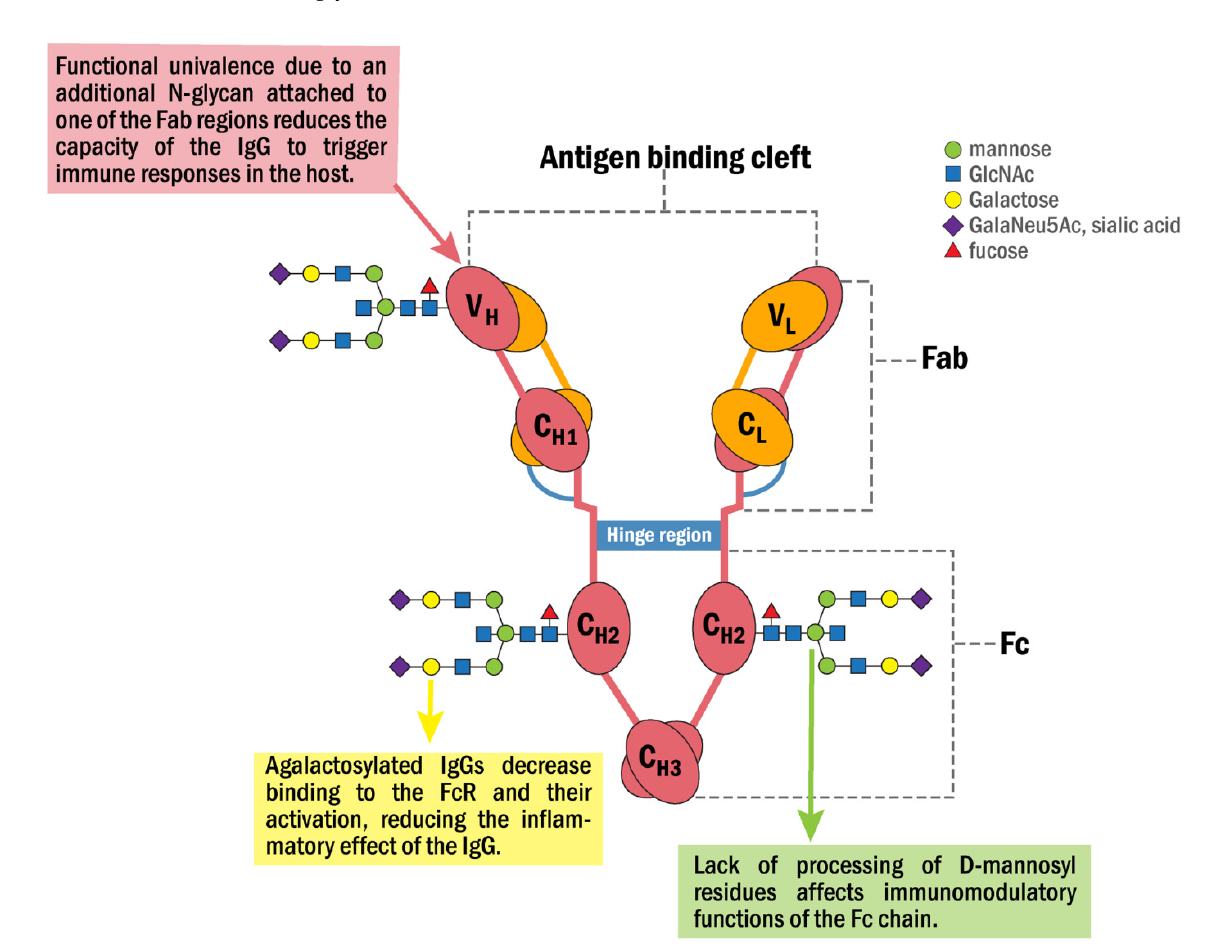
Figure 1. Schematic representation of the anti-GRP78 IgG molecular structure and its associated N-glycan structures identified in cancer patients. It consists of two interconnected heavy (H) and two light chains (L) with two domains that infer different properties, the fragment antigen-binding (Fab) and fragment crystallizable (Fc) domains. The Fab domain is responsible for recognizing and binding the antigen. The Fc domain contains two glycans attached to Asn 297 in conserved regions of the C H 2 domain. The Fc domain binds to the FcR on natural killers and other inflammatory cells. In cancer, the Fab region is asymmetrically glycosylated with one additional N-glycan that converts the anti-GRP78 IgG into a univalent molecule that binds the antigen with a decreased affinity, preventing it from triggering some IgG-linked functions of the immune response such as complement fixation, phagocytic activity and antigen clearance. Moreover, the N-glycans of the Fc region are aberrantly glycosylated, mainly at the levels of D-mannosylation and galactosylation with a reduction in the affinity of the antibody for the FcR and its activation, thus inhibiting the inflammatory effects of the IgG.